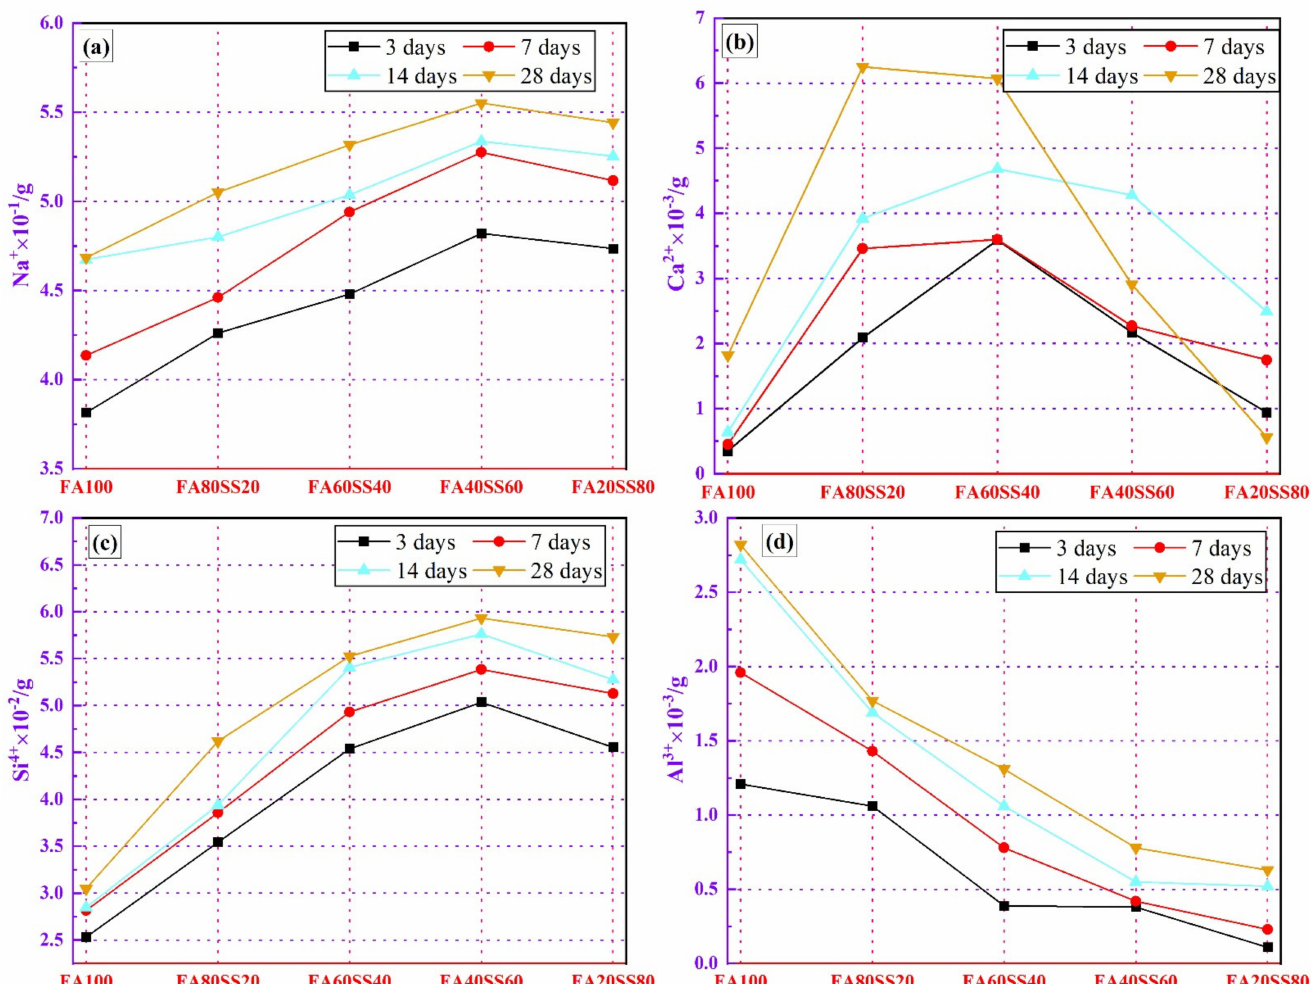
Figure 8. The content of ( a ) Na + , ( b ) Ca 2+ , ( c ) Si 4+ and ( d ) Al 3+ leached from the precast geopolymers at different periods of